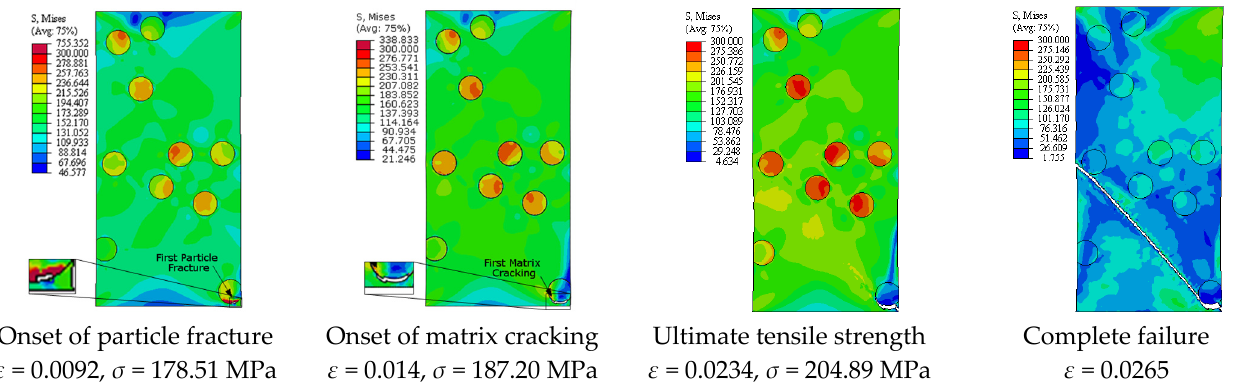
Onset of particle fracture Figure 17. Failure propagation and von Mises stress distribution of A359/SiC composite at PS = 20 µm (10% VF).